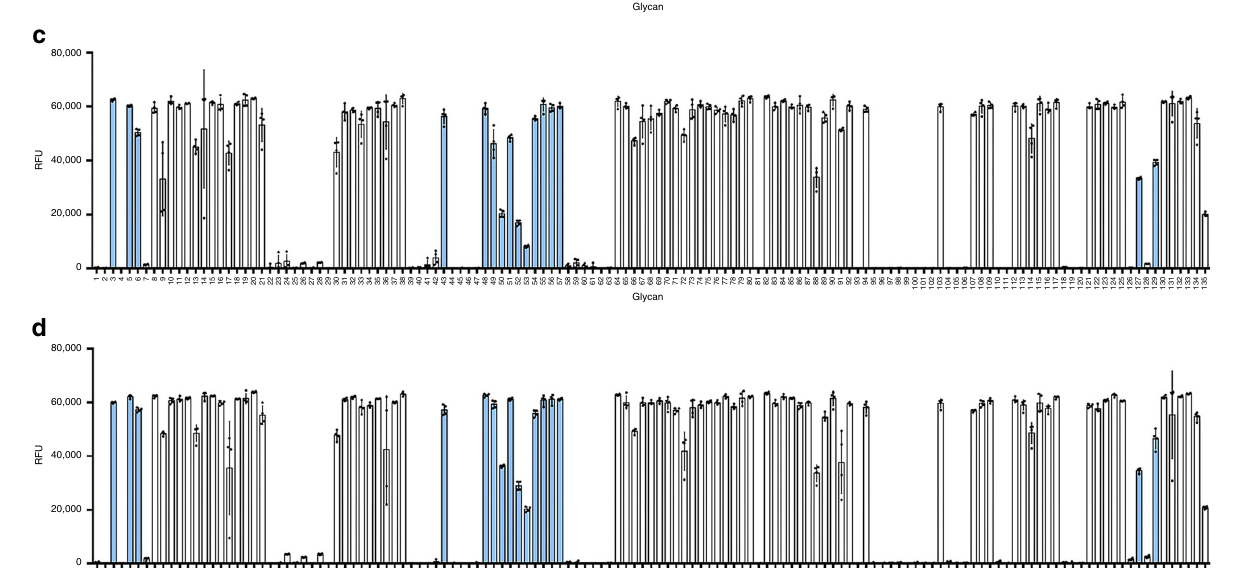
(Fig. 5a), in line with previous SPR data in which the binding of GDP-Fuc was ~40-fold stronger than the binding of G0 to the enzyme 26 (Fig. 5a). A G0 is recognized through hydrogen bonds formed between A G0 OH1 and Gly217 backbone, A G0 acetamide NH and Asp295 side chain, and A G0 OH3 and Asp295/Lys216 side chains. B G0 is tethered via interactions formed between B G0 OH6 and Glu373 side chain, and B G0 acetamide carbonyl group and Gln470 side chain. The unusual anti - ψ conformation of A G0 and B G0 , which is imposed by the enzyme, is a strict requirement for the A G0 OH6 fucosylation site facing GDP-Fuc (Fig. 5a). Catalysis can only take place in the anti - ψ conformation even though this conformation is less energetically favorable than the solution-phase